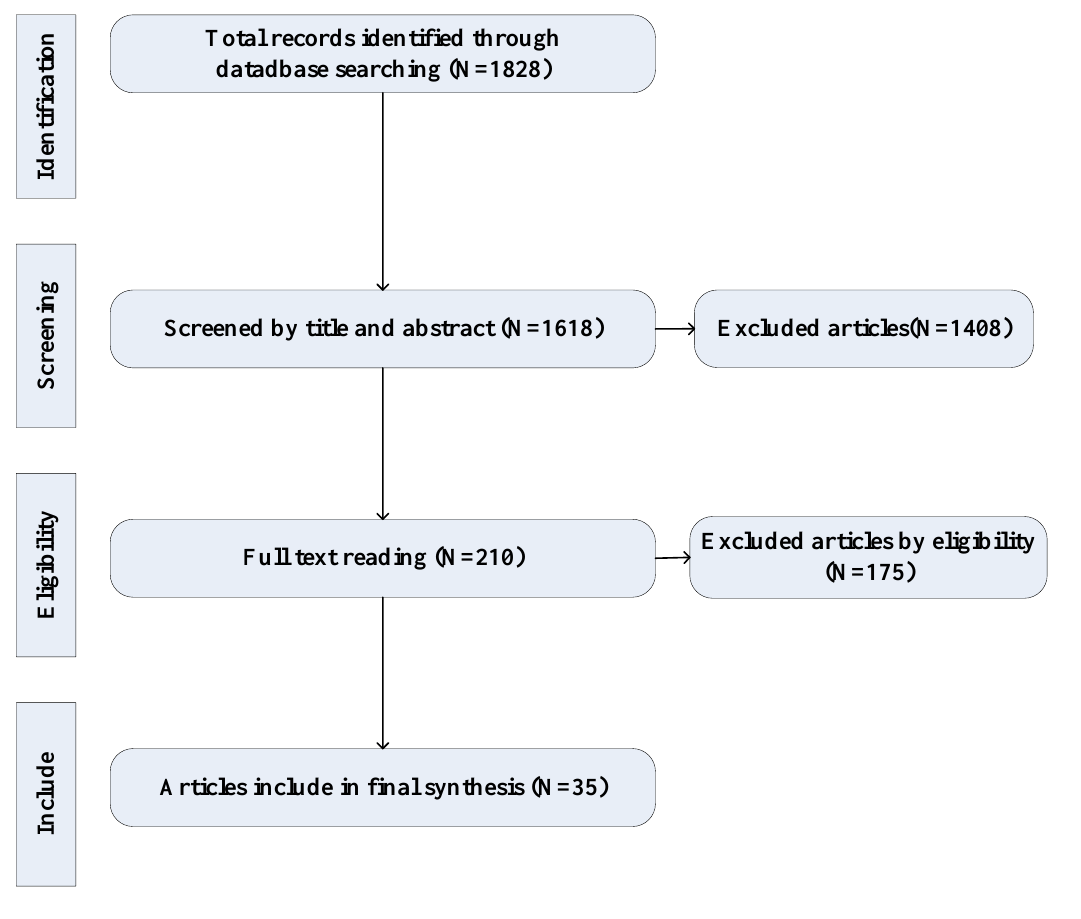
Figure 1. Flowchart for selecting articles on injuries and risk factors associated with coal mine casualties in China. Table 1. Results of the critical appraisal of cross-sectional and longitudinal